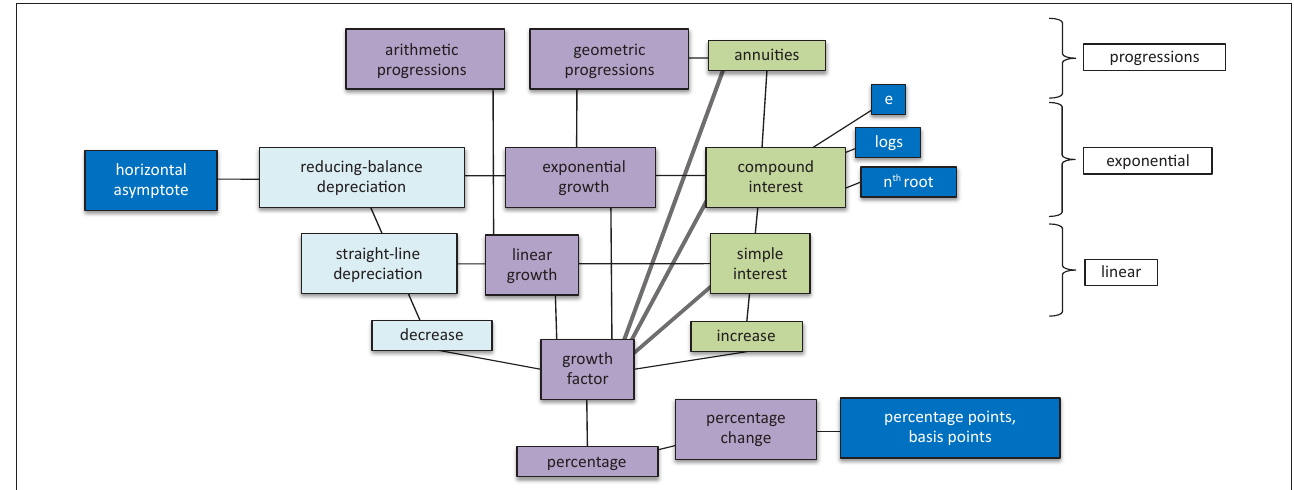
FIGURE 1: A hierarchy of interest